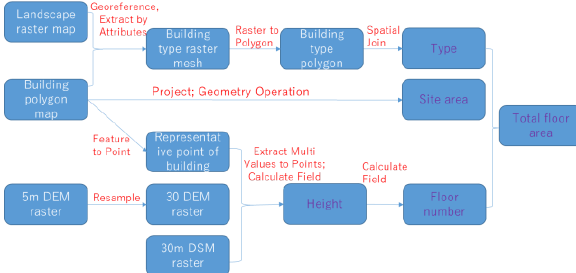
Figure 2. Data processing on attributes addition for buildings